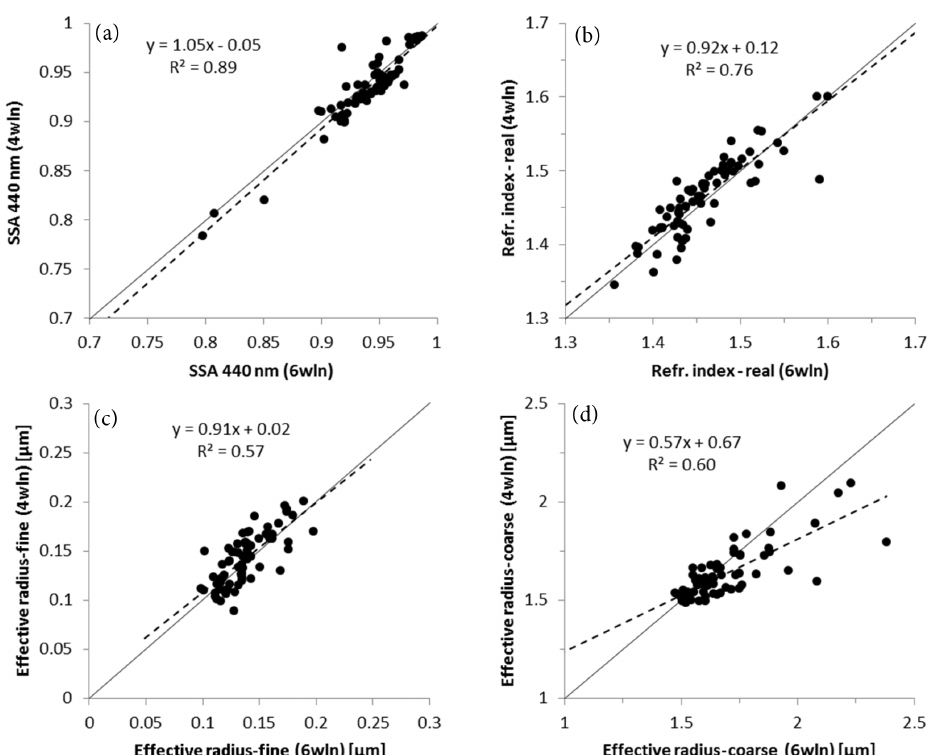
Figure 6. Comparison of inversion retrievals using four spectral channels (440, 675, 870 and 1020nm) or six channels (440, 500, 675, 870, 1020 and 1640nm) in the diffuse sky radiance: (a) single-scattering albedo (440nm); (b) the real part of the refractive index, (c) the effective radius of the fine mode, and (d) the effective radius of the coarse mode. Data from Cimel #789 at Barbados_Saltrace using almucantar and principal plane observations. Solid lines indicate the 1 : 1 line. Dashed lines indicate the linear fit to the displayed data, for which the line equation and correlation coefficient are also